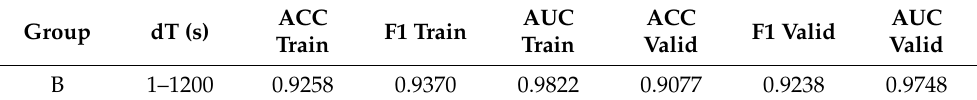
Table 3. GLM classifier results for Group B: all signals and full signal length.